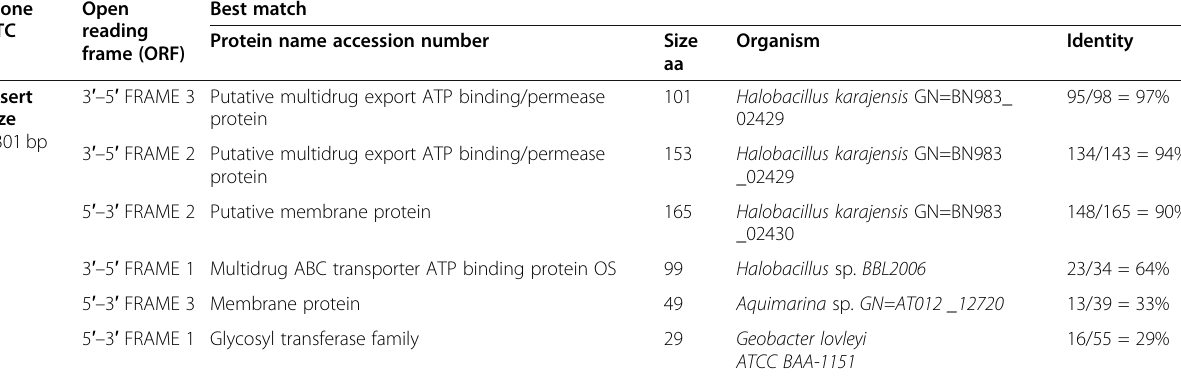
Table 1 Protein BLAST analysis of the H. trueperi SS1 genomic DNA insert present in STC. The predicted ORFs and their BLAST hits are